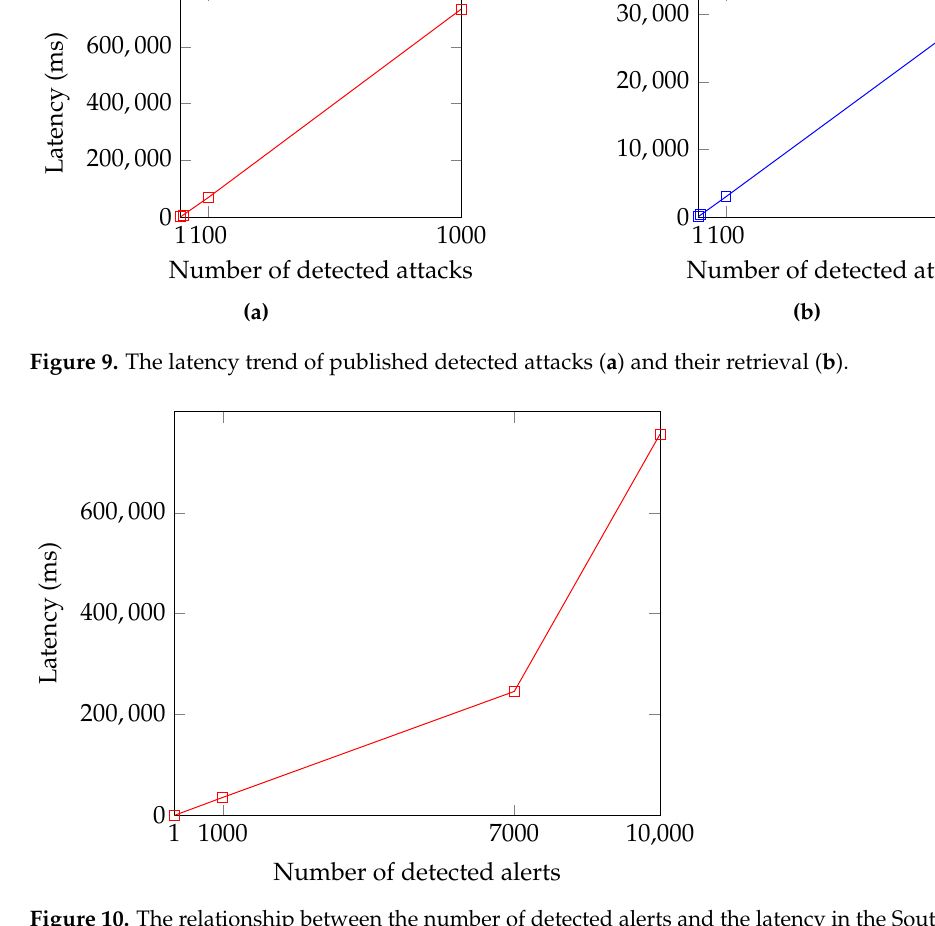
Figure 10. The relationship between the number of detected alerts and the latency in the Southbound Interface